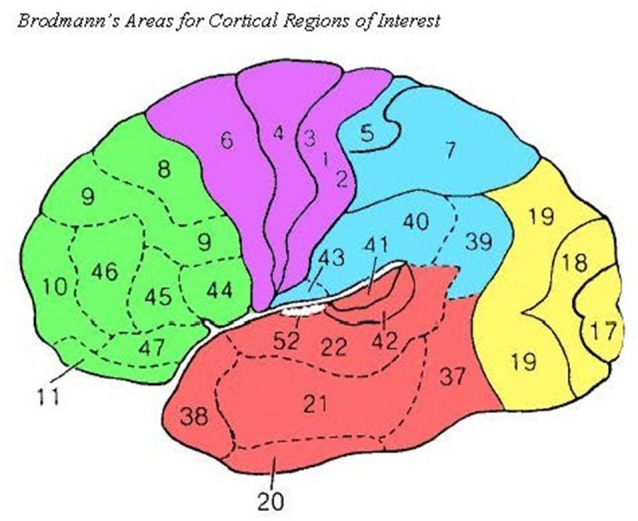
Source Brodmann’s Areas comprising cortical ROIs are noted above as in Babiloni et al. (2017). Frontal (green): 8, 9, 10, 11, 44, 45, 46, and 47; Central (purple): 1, 2, 3, 4, and 6; Temporal (red): 20, 21, 22, 37, 38, 41, and 42; Parietal (blue): 5, 7, 30, 39, 40, and 43; Occipital (yellow): 17, 18, and 19.